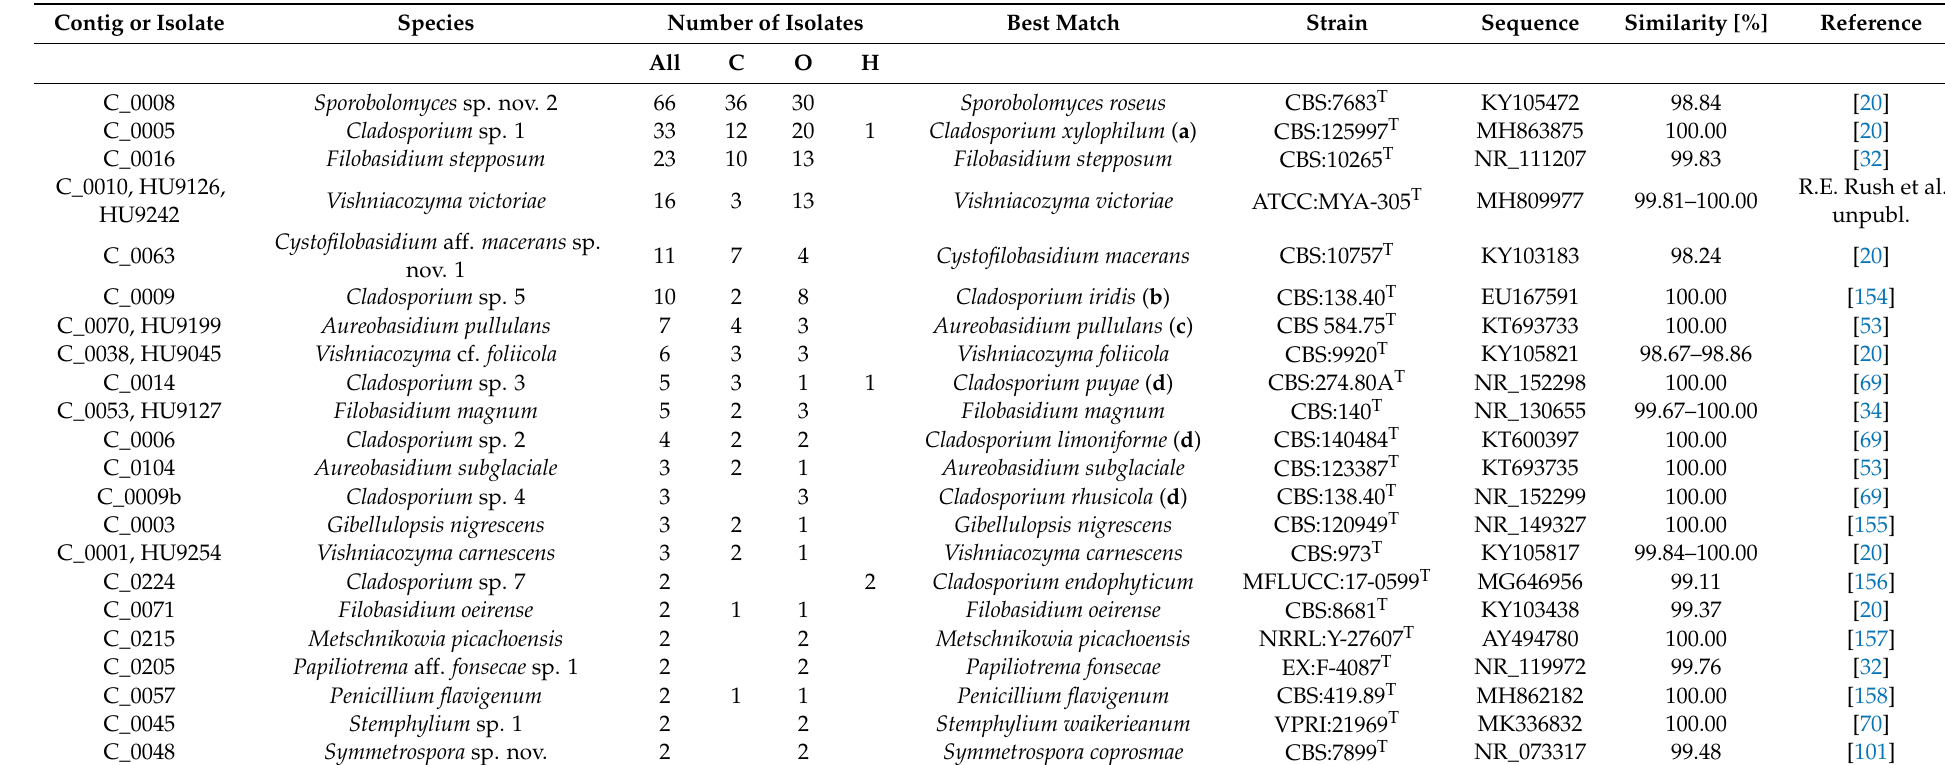
Table A1. Results from BLAST searches of contigs (with multiple identical isolates) or individual isolates in tabular format. For each contig or isolate, the following are shown: species name, number of isolates (total and by treatment: C, conventional; O, organic; H, hydroponic) and best match information (species name, strain information, GenBank accession number, type status, percentage of similarity and reference in which the sequence was first published). Query coverage was between 75 and 100% for all BLAST